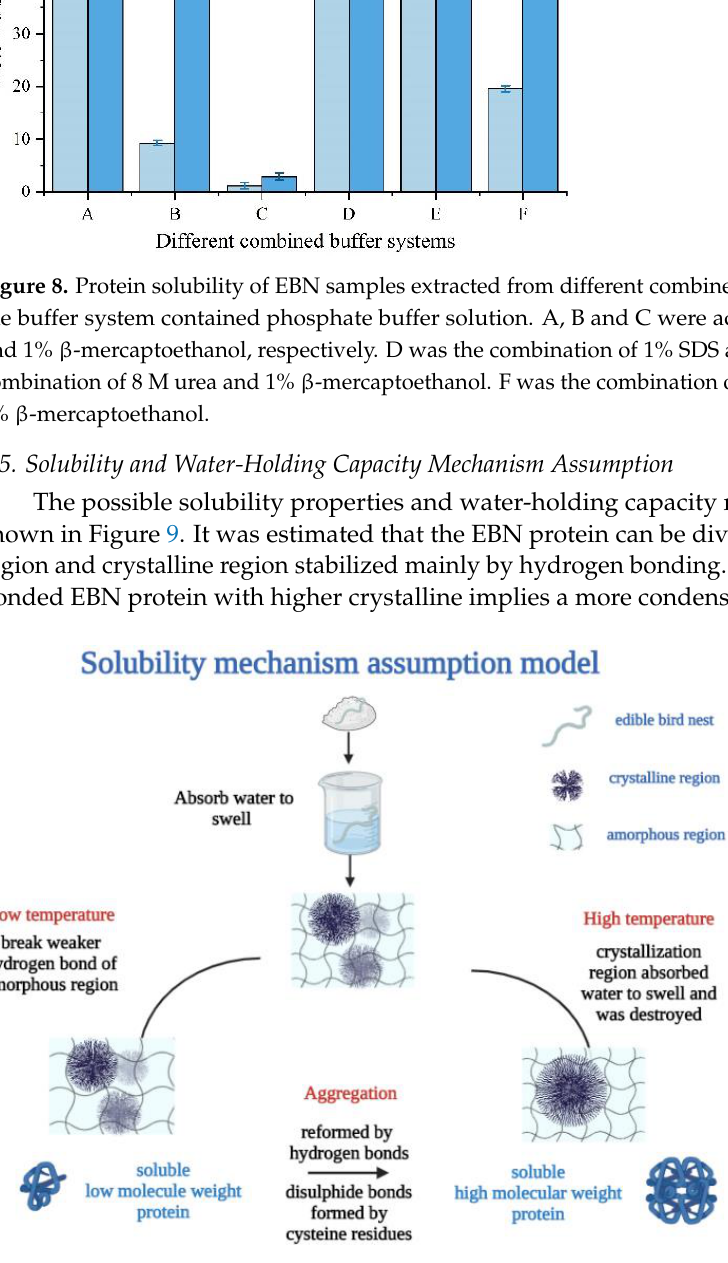
Figure 9. Solubility and water-holding capacity mechanism assumption model of EBN.